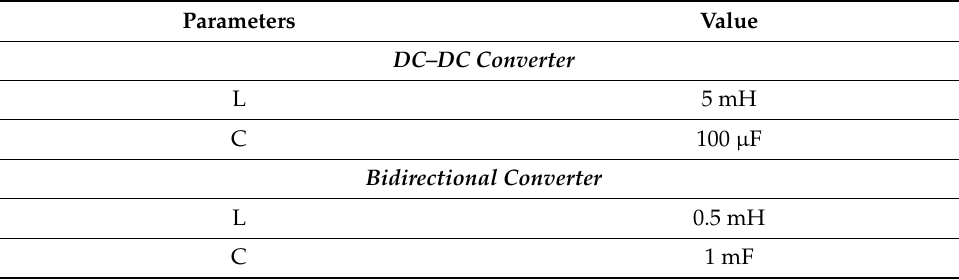
Table 4. Electric vehicle design parameters.